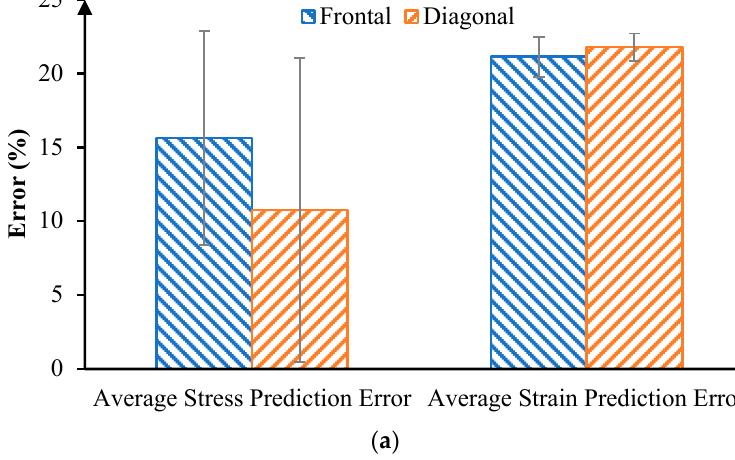
Figure 7. Comparison of FE simulated von Mises stress pattern, and PLSR-predicted von Mises stress (soccer ball velocity was 40 mph and 30-degree angle impact location). General agreements can be seen in the location and magnitude of maximum stress.